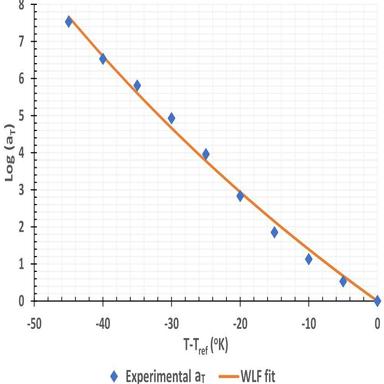
WLF model fit to the experimental shift factors.